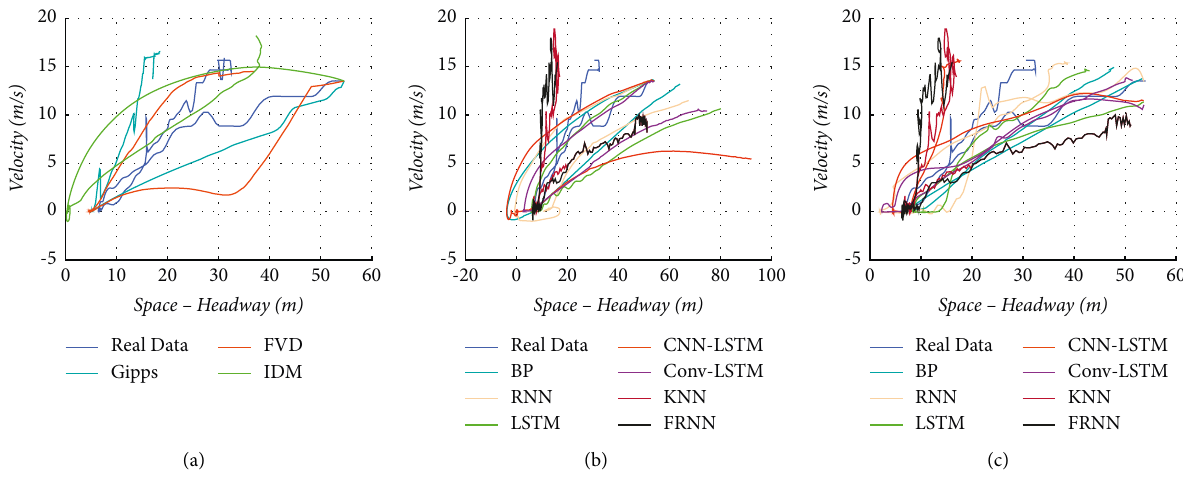
Figure 21: Hysteresis loops comparison of discontinuous traffic flow. (a) Conventional model; (b) ANN CF-A; and (c) ANN